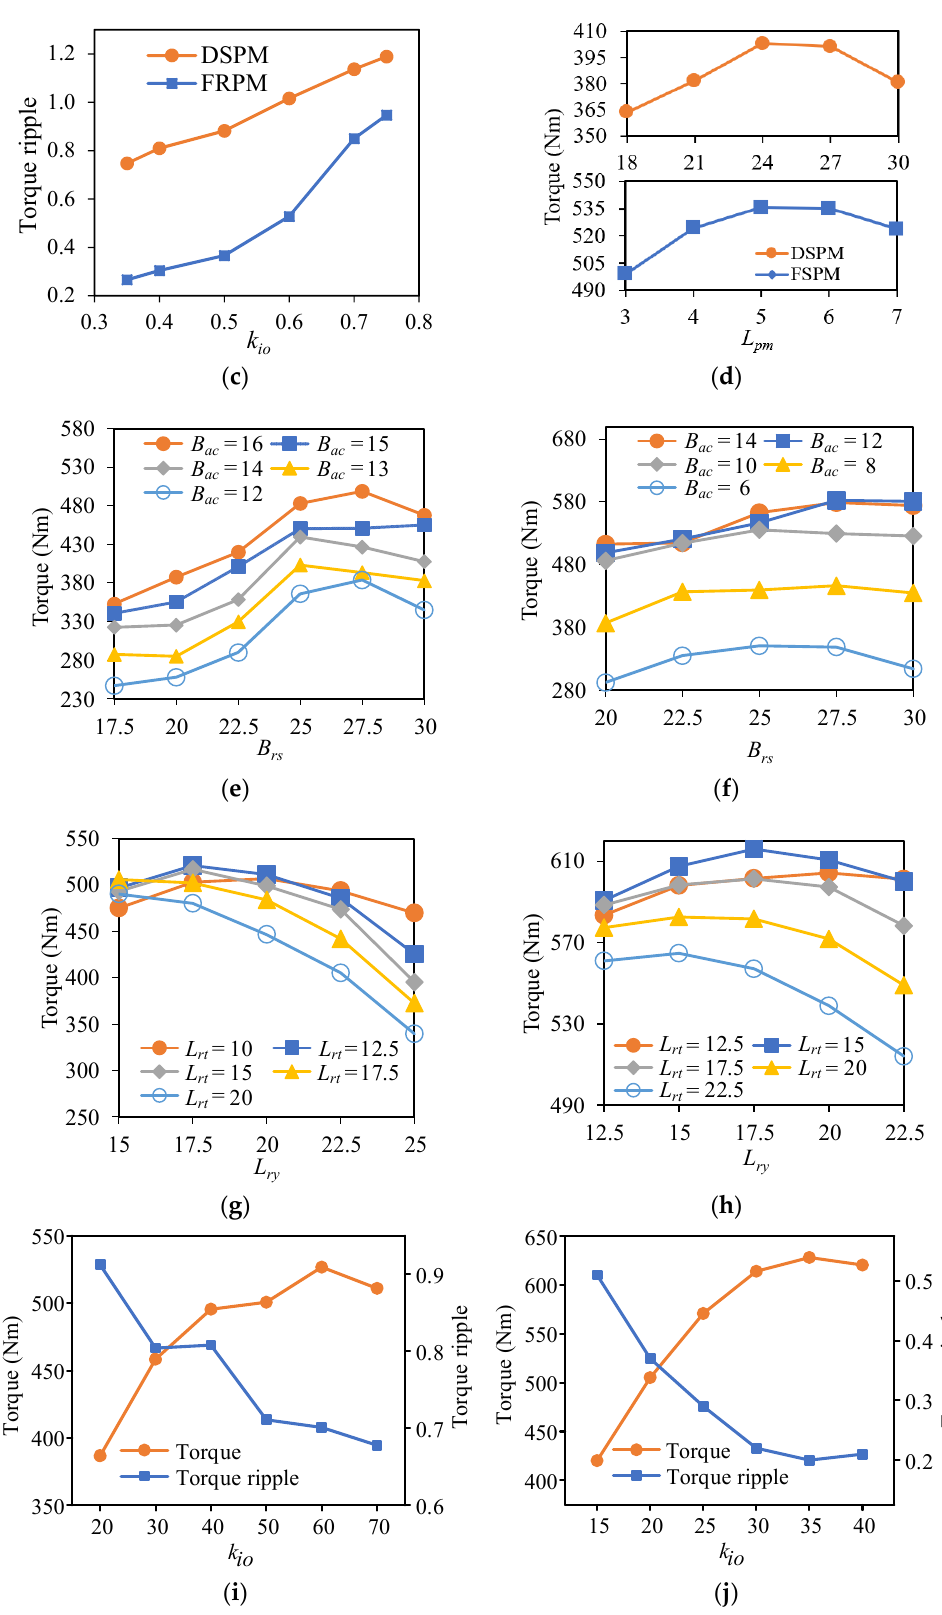
Figure 4. Optimization results. ( a ) k io —DSPM, ( b ) k io —FRPM, ( c ) torque ripple vs. k io , ( d ) torque vs.